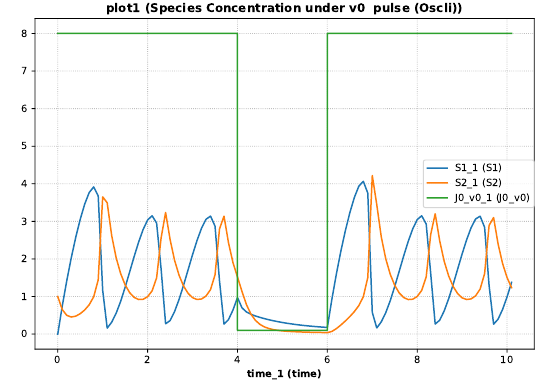
Figure A.9: The simulation result from the simulation description given in List- ing A.6. Simulation with SED-ML web tools [2].